Question: Based on the figure, does the quantity rise or fall?
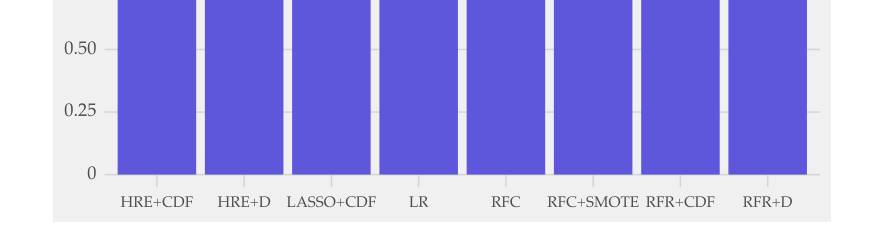
Answer: increasing